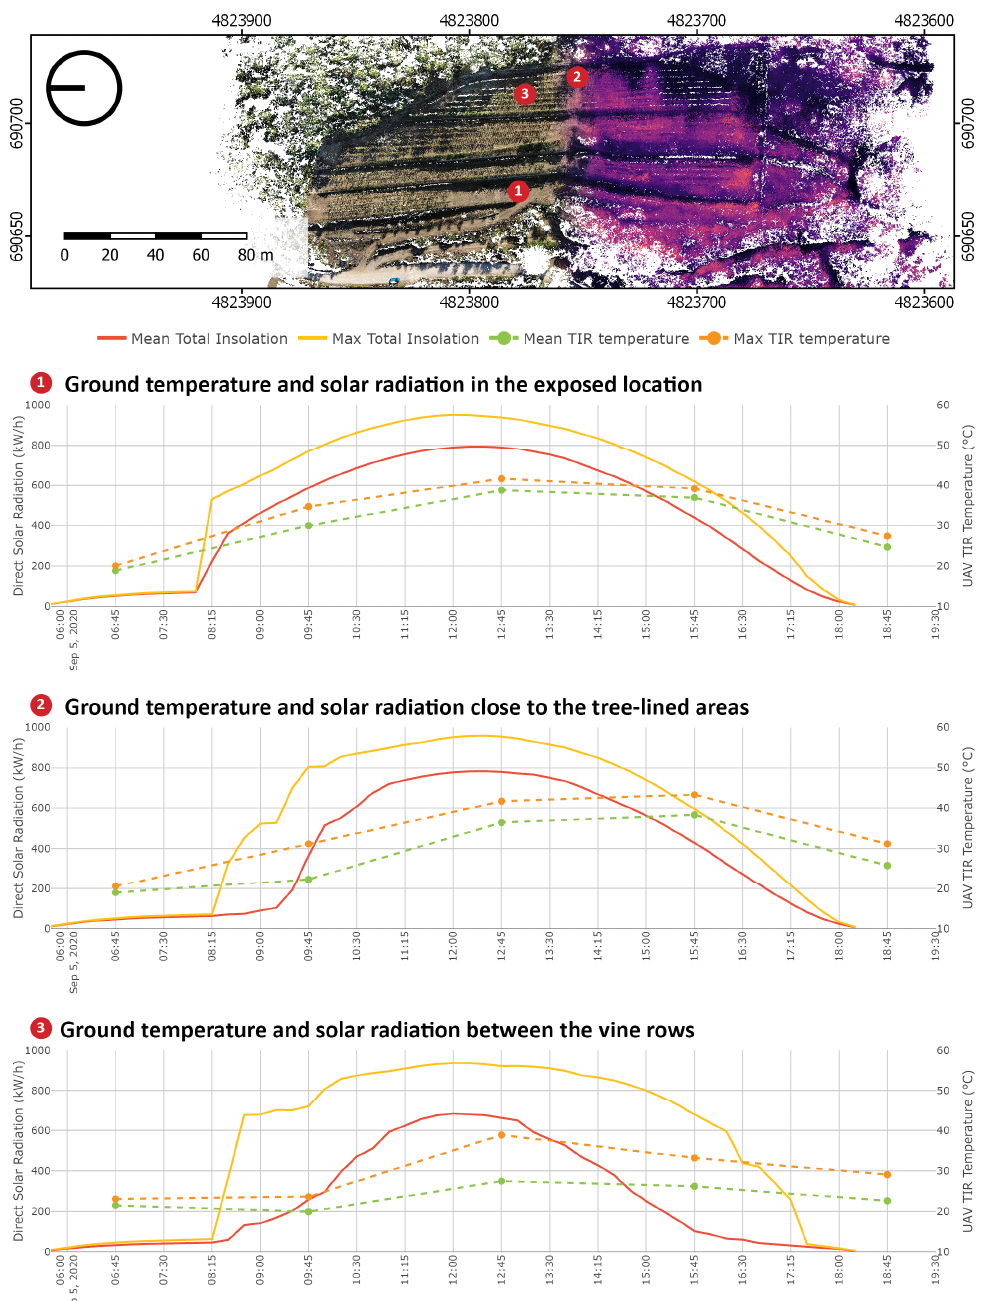
Figure 8. Top view of the voxel model with characteristic locations in the vineyard marked with numbers: ( 1 ) The ground in a strongly exposed location, ( 2 ) close to the edge of the forest and ( 3 ) in between the vine rows. The corresponding graphs on the left show measured daily temperature variation (DTV) compared with simulated solar exposure.